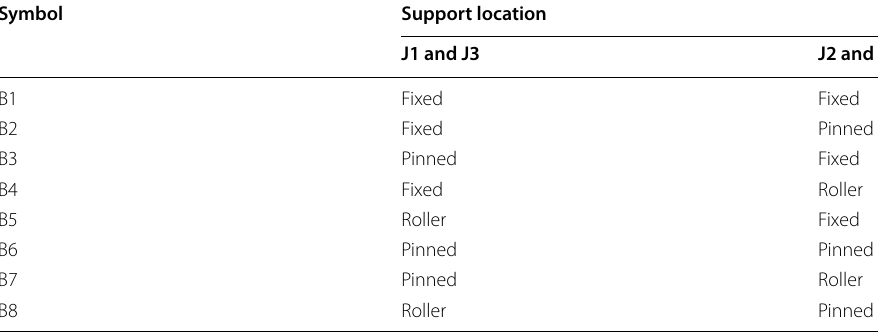
Table 1 Boundary conditions of the historic truss bridge Symbol